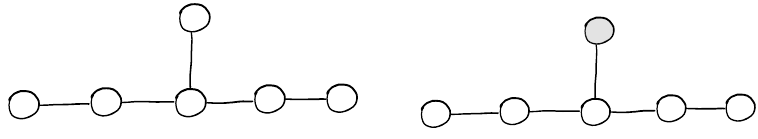
Figure 37 . The Dynkin diagram of E 6 (cid:2) E 6 with the shaded node corresponding to node with